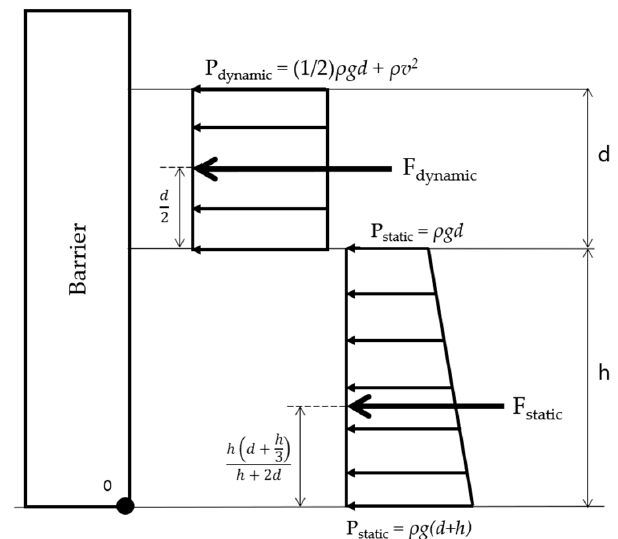
Figure 10. The combination of pressures applied to the barrier surface from the dynamic and static debris-flow clusters. The pressure distributions are separated for clarity. The point O refers to the pivot point at which the moment applied to the barrier by the debris-flow clusters is computed.